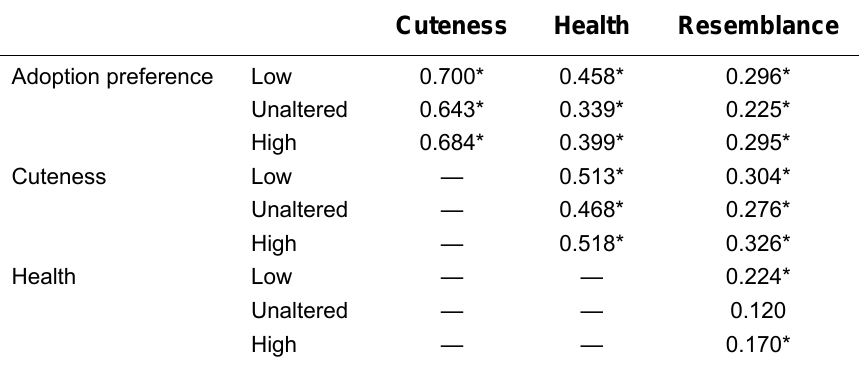
Within-Stimuli Average